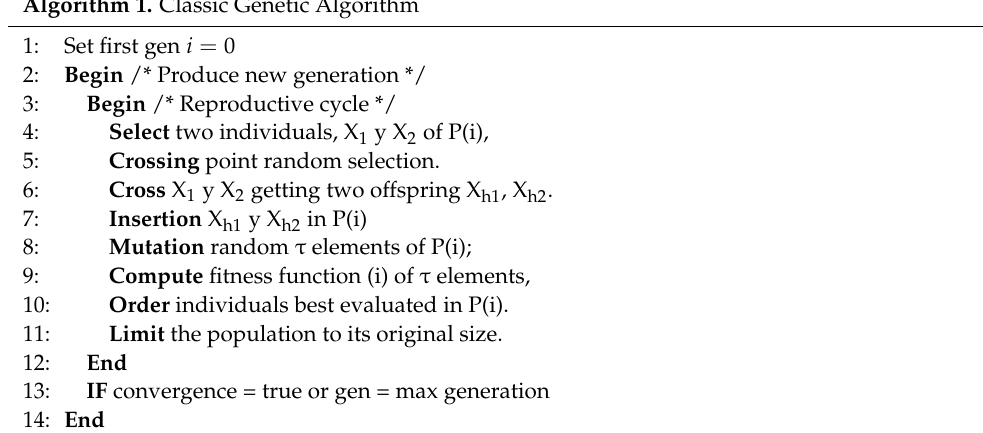
Algorithm 1. Classic Genetic